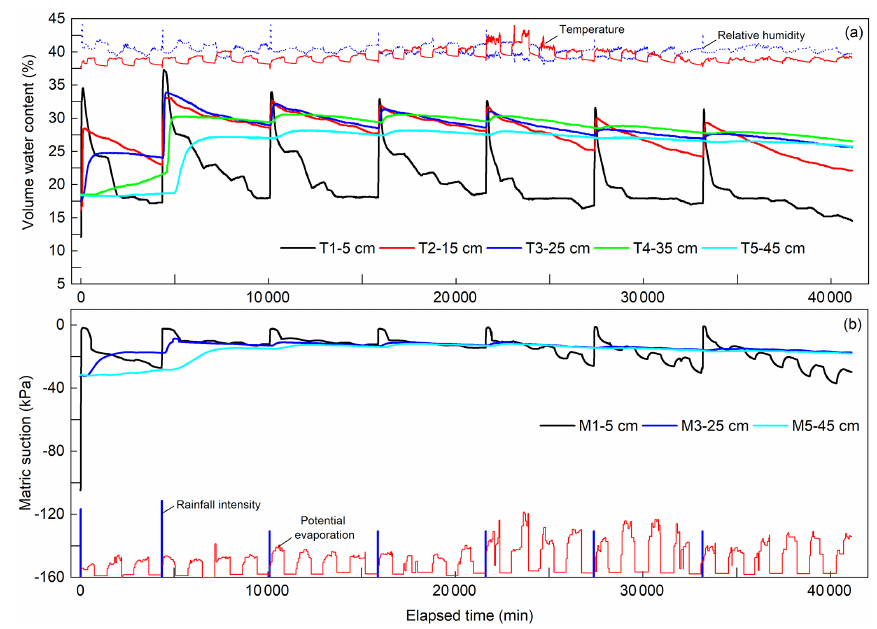
Figure 8. Time series of volume water content (a) and matric suction (b) at different depths.